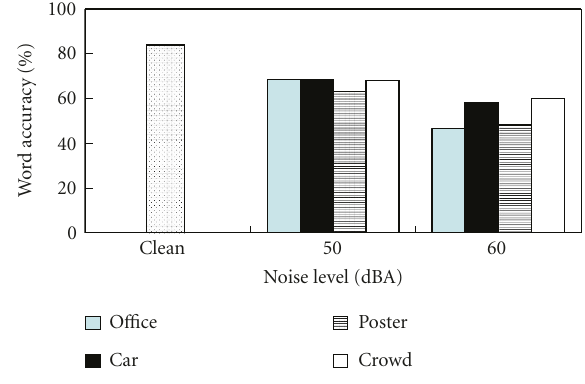
Figure 9: Nonaudible murmur recognition using various types of